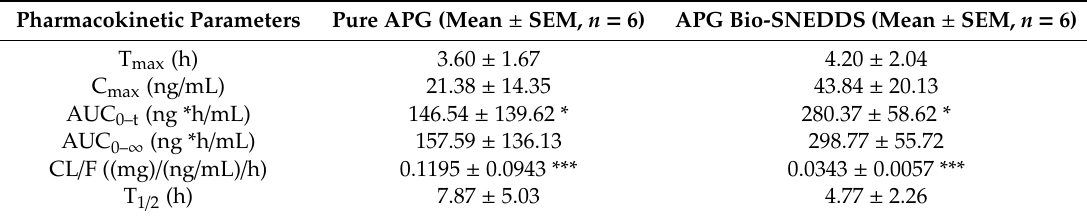
Table 6. Pharmacokinetic parameters of pure APG powder vs. the APG-loaded Bio-SNEDDS (formulation used: F11-CoFA:CMCM:TC (3:1:1)/HCO30 [1/1]). Pharmacokinetic Parameters